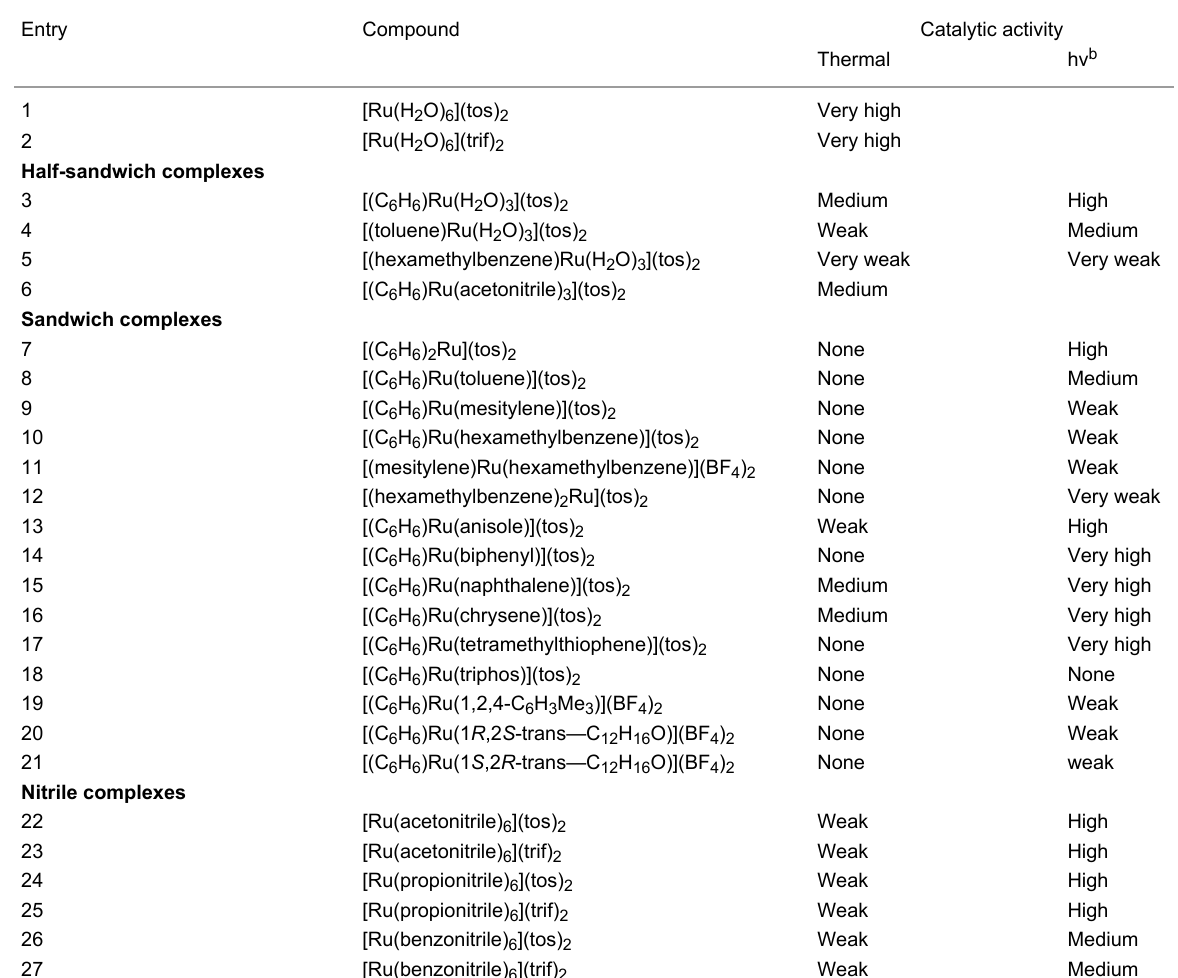
Table 1: Activation of ruthenium complexes with and without irradiation a .